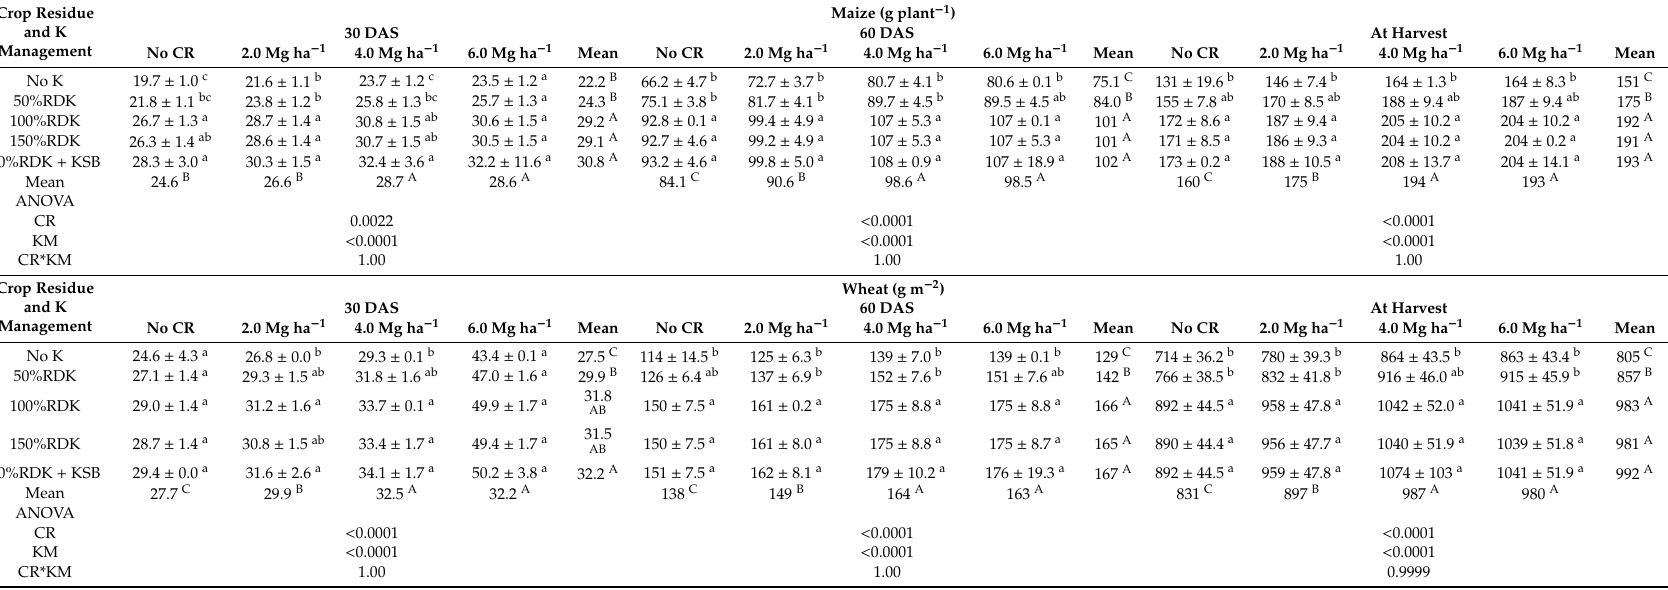
Table 1. Crop residue and potassium management practices on dry matter production of maize and wheat at di ff erent crop growth stages in zero tillage maize–wheat system (pooled data of two